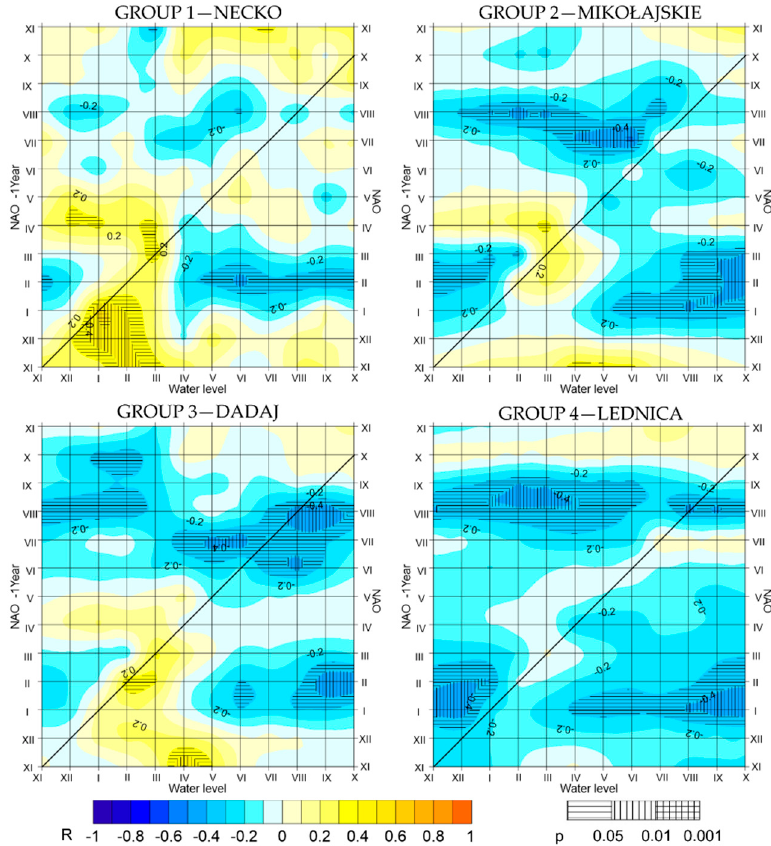
Figure 5. Matrices of coefficients of correlation for selected lakes in the designated groups (NAO).